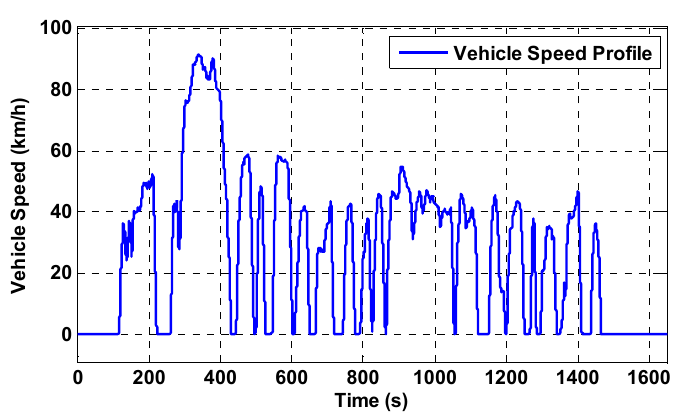
Figure 10. FTP-72 driving